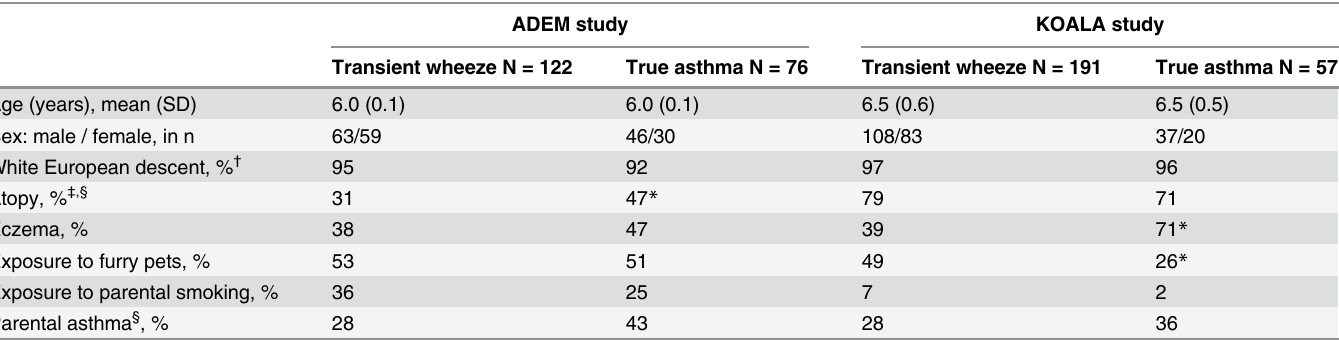
Table 1. Characteristics of the study populations.